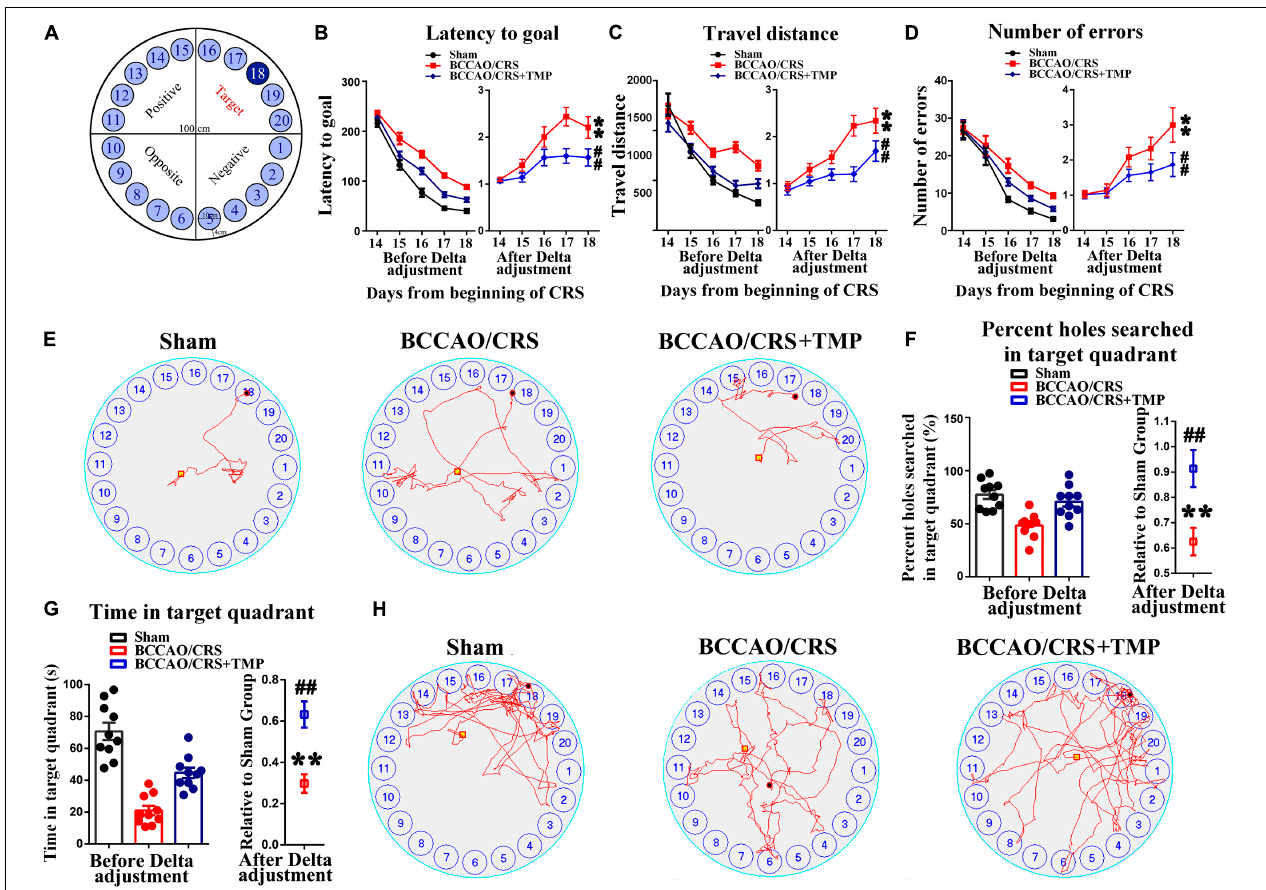
FIGURE 5 | TMP ameliorates learning and memory deficits in BCCAO/CRS rats. (A) The diagrammatic sketch of the zone and magnitude of Barnes maze instrument. (B) Chart showing the average latency of rats finding out the escape tunnel in different groups from day 15 to 19. (C) The average traveled distance of rats finding out the escape tunnel in different group from day15 to 19. (D) Total number of errors during experiments in different groups from day 15 to 19. (E) Representative traces of rats finding out the escape tunnel on day 19 in various groups. (F) Percentage holes searched in the target quadrant during the probe trial. (G) Total time of rats spent on exploring the target quadrant during the probe trial. (H) Representative trajectories in the quadrant zone during spatial memory probe trial. ∗∗ P < 0.01 vs. Sham. ## P < 0.01 vs. BCCAO/CRS. Data are presented as mean ± SE. n = 10 in each